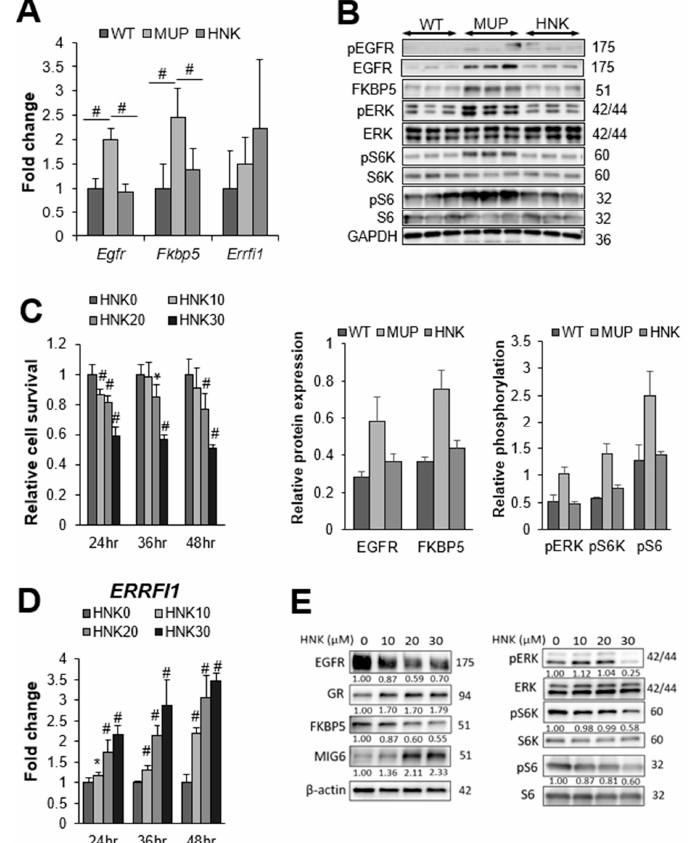
Figure 3. Honokiol (HNK) treatment suppresses epidermal growth factor receptor (EGFR) signaling in the non-alcoholic steatohepatitis (NASH) liver. ( A ) Relative expression of Egfr , FK506 binding protein 5 (Fkbp5), and ERBB receptor feedback inhibitor 1 (ERRFI1) mRNAs in non-tumor livers from major urinary protein (MUP)-urokinase type plasminogen activator (uPA) transgenic mice receiving vehicle control (MUP) or HNK and their wild-type (WT) littermates receiving vehicle control ( n = 5 per group). All mice were fed a high-fat diet (HFD) from 6 weeks of age until sacrifice at 40 weeks of age. Results are presented as the mean ± SD (# p < 0.01). ( B ) Immunoblot analysis of the non-tumor liver extracts from WT, MUP, and HNK mice. Protein expression and phosphorylation of EGFR signaling-related molecules, and FKBP5 are presented ( n = 3 per group). Glyceraldehyde-3-phosphate dehydrogenase (GAPDH) was used as a loading control. ( C ) Relative cell viability and proliferation, and ( D ) relative ERRFI1 mRNA expression in Hep3B cells 24, 36, and 48 h after incubation with 0, 10, 20, or 30 µ M HNK. All graphs represent the mean ± SD (* p < 0.05, # p < 0.01 vs. HNK0 condition at the same time course). ( E ) Immunoblot analysis of Hep3B cells 24 h after incubation with the indicated concentrations ( µ M) of HNK. Protein expression and phosphorylation of EGFR signaling-related molecules are presented. β -actin was used as a loading